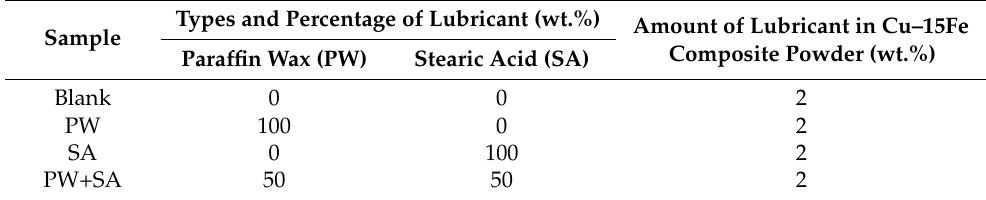
based powder. Types and Percentage of Lubricant Sample